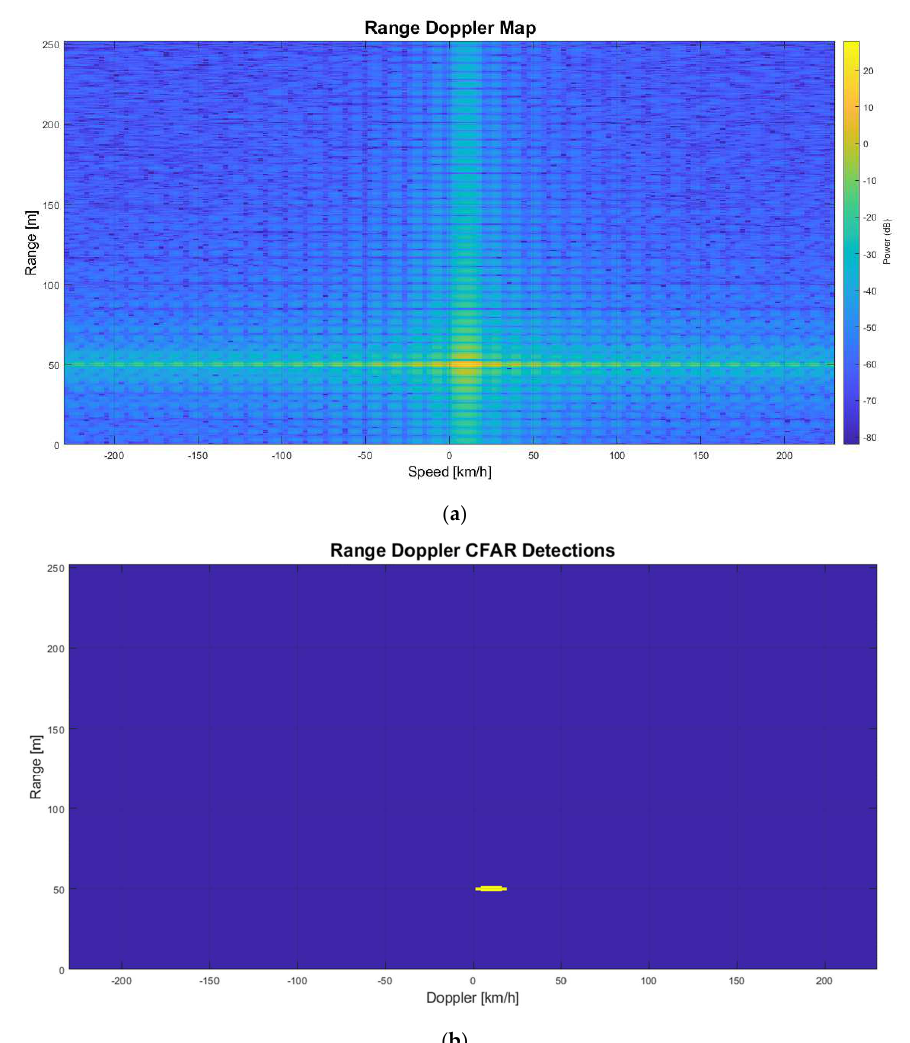
Figure 9. No jamming. ( a ) Range-Doppler Map; ( b ) 2D-CFAR Detection. When the jammer on the front automobile starts jamming, the LRR detects both jam- ming and echo signals. At first, the JSR is considered as 0 dB which means the jamming signal has the same power level of the echo signal. Figure 10a,b show the RDM and 2D- CFAR detection, respectively, when the JSR is 1. The real echo is in the 50 m range, and the 10 km/h relative speed and ghost echo are in the 40 m range and 15 km/h relative speed in both RDM and 2D-CFAR figures.